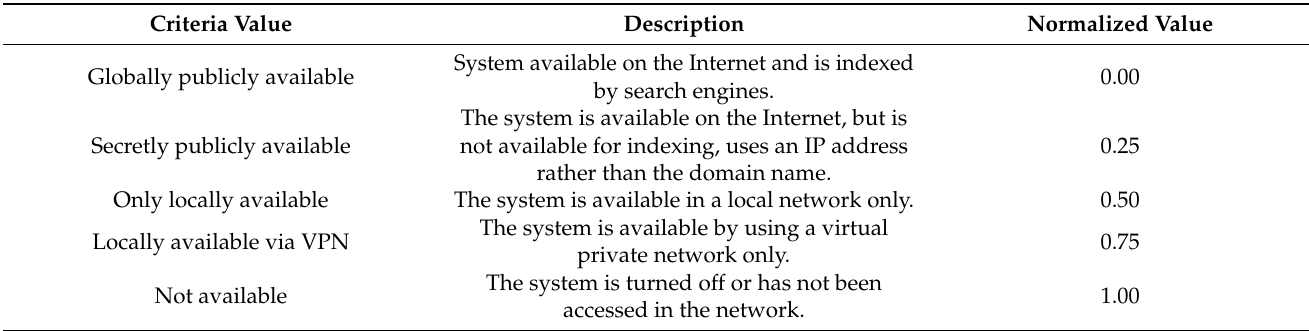
Table 3. Criteria value association to normalized value for sub-criteria system access.